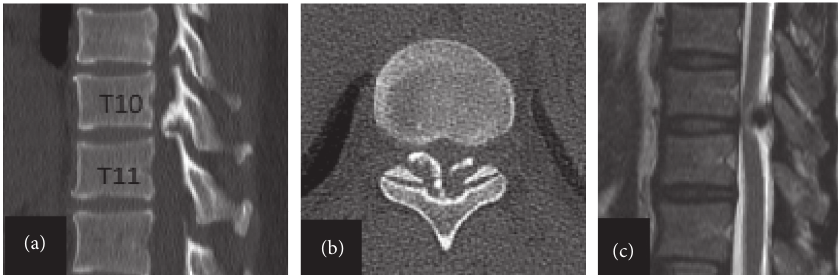
Figure 3: A 62-year-old male patient of the dissatisfied group. A 62-year-old male patient (a, b, and c) of the dissatisfied group Ossification of the ligamentum flavum at the T10–11 intervertebral disc level. The main preoperative symptoms of the patients were numbness, weakness of both lower limbs, and difficulty in walking with urination disorder for more than 2 years. Physical examination showed a sense of banding in the chest and abdomen, knee hyperreflexia, and Babinski sign (+). He was performed with laminectomy without related complications. At 6-month and 1-year follow-up, the symptoms of significantly limited physical activity were relieved. However, the improvement of urination disorder was not obvious, which had been troubling the patients after operation and seriously affected the quality of life of the patients. At the last follow-up, her JOA scores improved from 3 before operation to 7 after